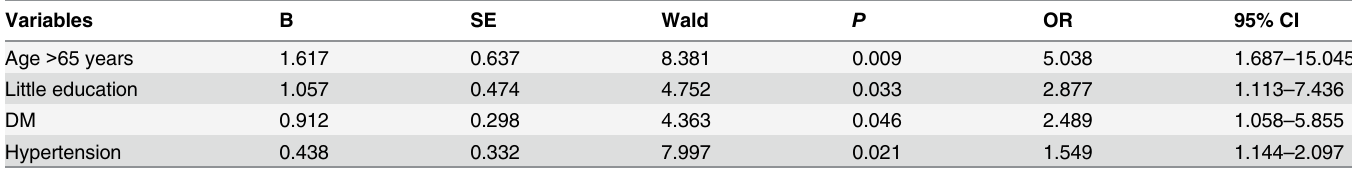
Table 3. Independent risk factors of deteriorated MoCA Scores 3 years after CAS in CLI patients: results of multi-variable adjusted logistic regres- sion analysis. Variables